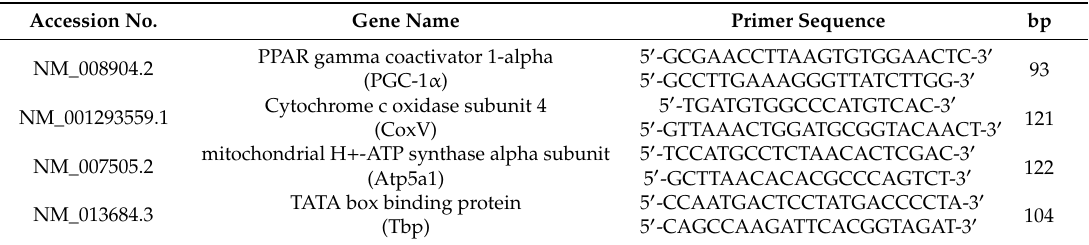
Figure 2 . Body weight in each group. Body weights were measured before euthanasia at each time point. Values are means ± SE ( n = 7–9).